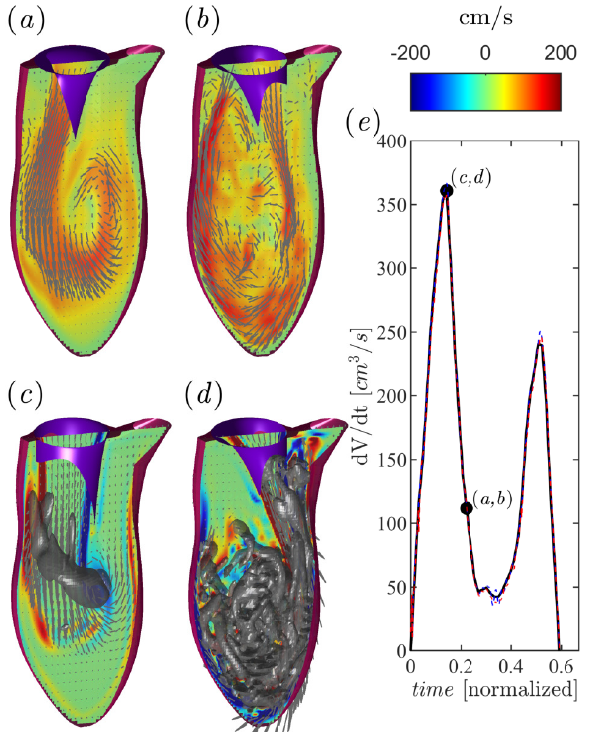
Figure 2. Velocity field of MV with ( a ) (cid:101) = 0.6, ( b ) (cid:101) = − 0.6; flow field of MV with ( c ) (cid:101) = 0.6, ( d ) (cid:101) = − 0.6 as indicated in the box of the dV/dt curve ( e ); the normal vorticity is shown in red to blue color from − 200 units to 200 units (cm/s) equal to the inverse of the heartbeat period and the velocity vector (every 4 grid points) on a longitudinal plane crossing the center of MV of the aorta and the LV apex; the three-dimensional gray surfaces represent one isosurface of the λ 2